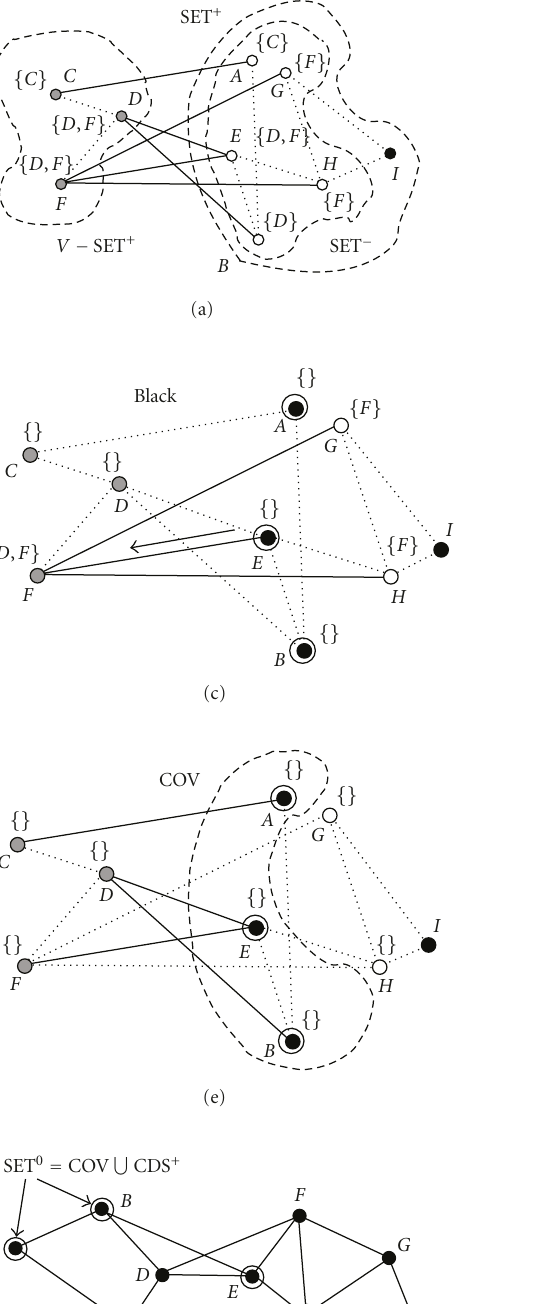
and have larger ζ and lower available power. An MCDS con- taining such burden nodes is more likely to be reorganized from time to time whenever any burden node uses up its power. While the metric of our BACDS construction algo- rithm is to balance the power consumption among sensor